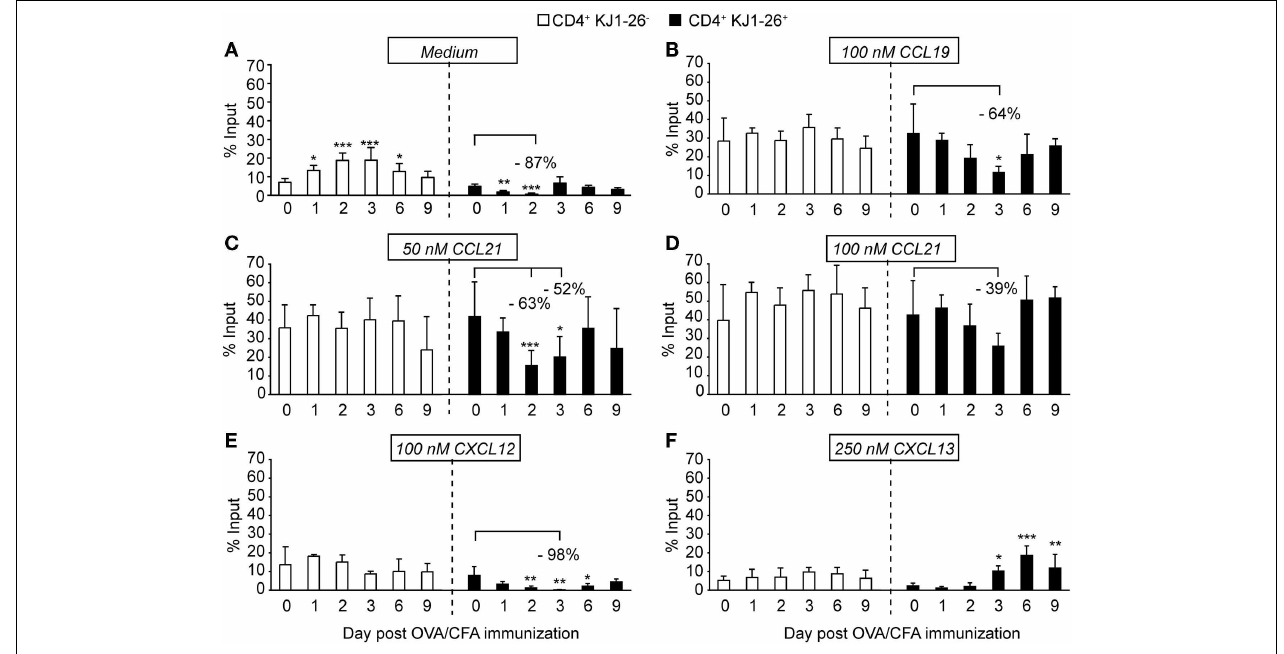
subtracted in (B–F) to focus on chemokine-induced motility. Bars represent mean (cid:6) SD of % input and were pooled from three to four independent experiments combining three to eight mice per time point. Statistical analysis was performed separately for endogenous CD4 + T cells and KJ1–26 + DO11.10 CD4 + T cells using ANOVA test against “Day 0” values ( = control migration) followed by Dunnett’s multiple comparison test. * p < 0.05; ** p < 0.01; *** p <